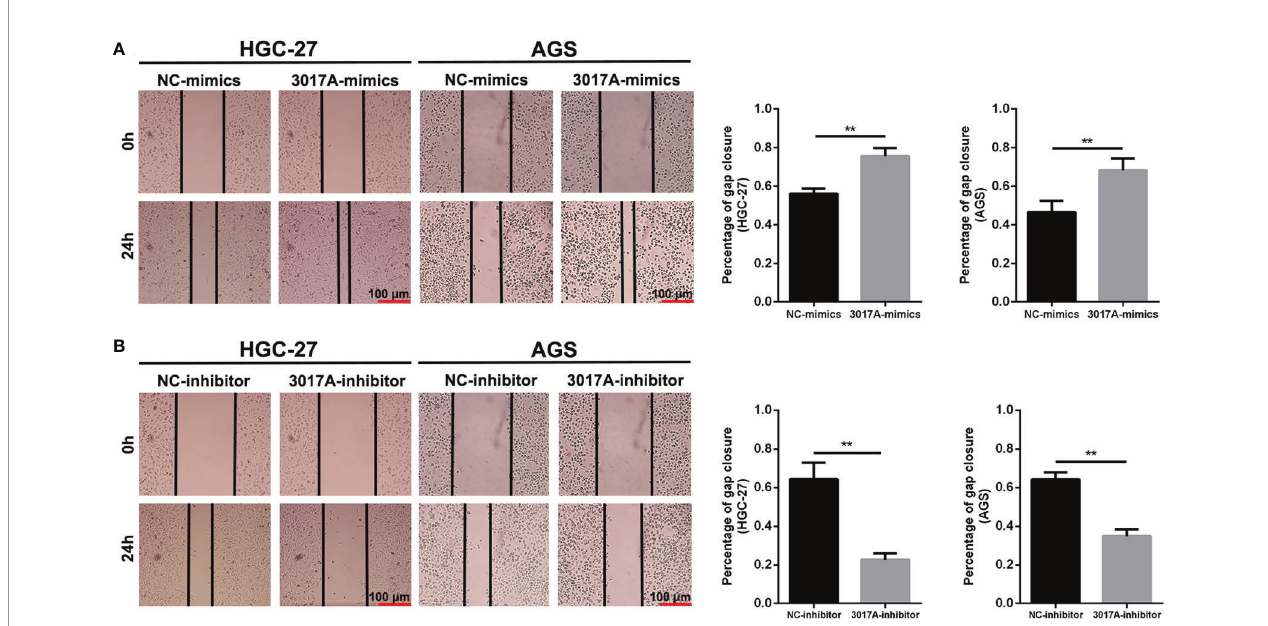
FIGURE 3 | The scratch wound healing assay on GC cell lines. (A) The scratch wound healing assay was used to determine the cell motility ability in GC cell lines HGC-27 and AGS transfected with tRF-3017A-mimics or NC-mimics. (B) The scratch wound healing assay was used to determine the cell migration ability in GC cell lines HGC-27 and AGS transfected with tRF-3017A-inhibitor or NC-inhibitor. Representative images and bar graphs were depicted. Data are shown as mean ± SD. NC, negative control. **P <